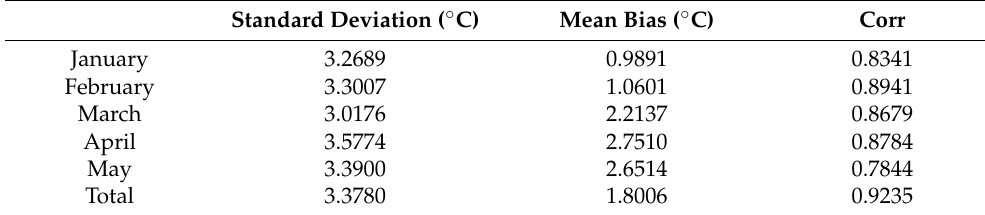
Table 8. Analysis of the monthly L4 IST and FY-3D/MERSI IST